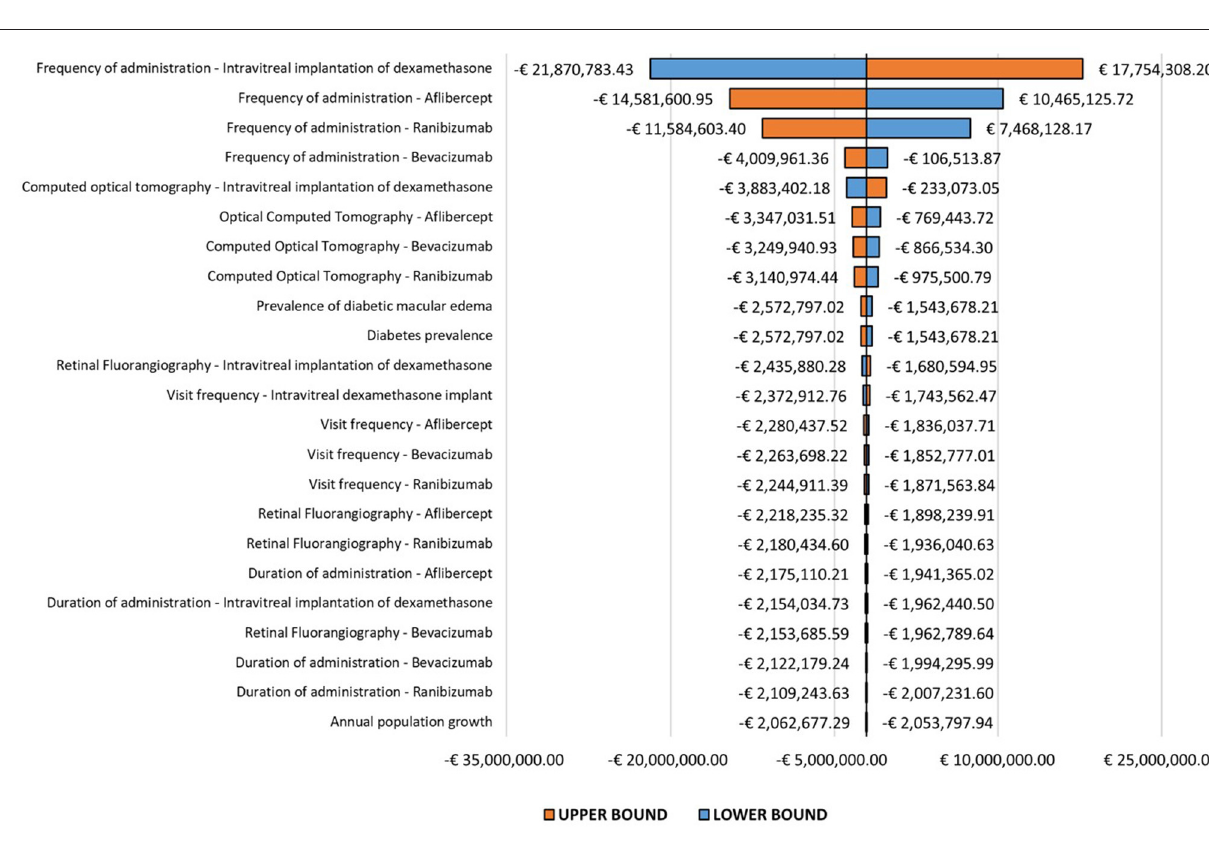
FIGURE 2 | One-way sensitivity